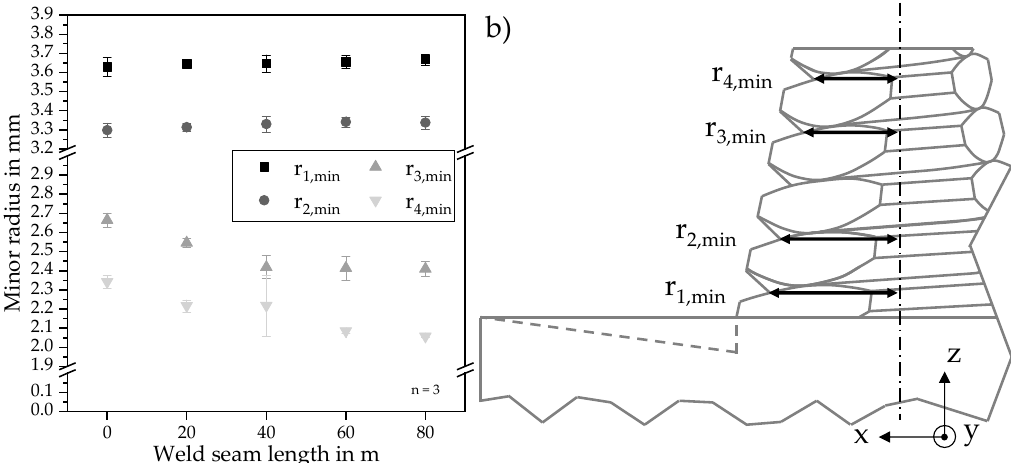
Figure 8. Wear deviation of the minor thread radius as a function of the weld seam length in ( a ) measured with stripe light projection and ( b ) at the measuring points.